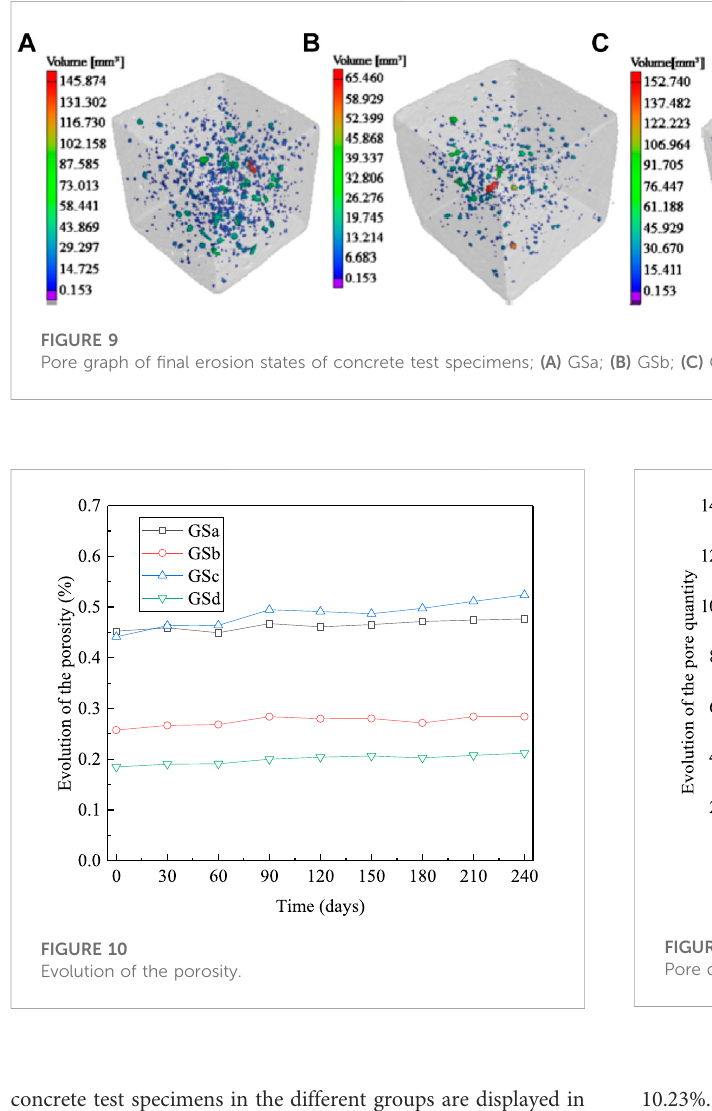
10.23%. In the GSc group, the average porosity was initially 0.44%, that at 120 days was 0.49% with an increase amplitude of 11.25%, and that at 240 days was 0.52% with an increase amplitude of 18.63%. In the GSd group, the average porosity was initially 0.18%, that at 120 days was 0.20% with an increase amplitude of 10.43%, and that at 240 days was 0.21% with an increase amplitude of 14.65%. The porosity of concrete specimen fl uctuation increased with the rise in drying – wetting cycle erosion time. However, the overall increase was small. After erosion to 240 days, the increase amplitude of porosity was sorted in a descending order as follows: GSc > GSd > GSb > GSa group. The pore quantity in the different groups is presented in Figure 11. Within the fi rst 30 days of erosion, the pore quantity rapidly increased, and it declined somehow at day 60. The pore of GSa, GSb, and GSc groups showed a fl uctuation increasing trend after 60 days of erosion, while the fl uctuation margin of GSd group was relatively small. At the same time, the increase in pore